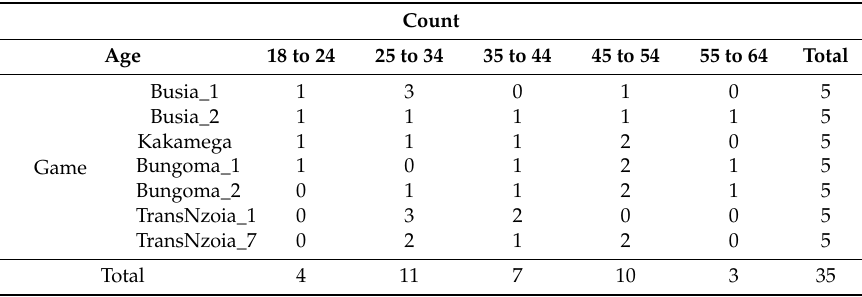
Table A2. Game * Age